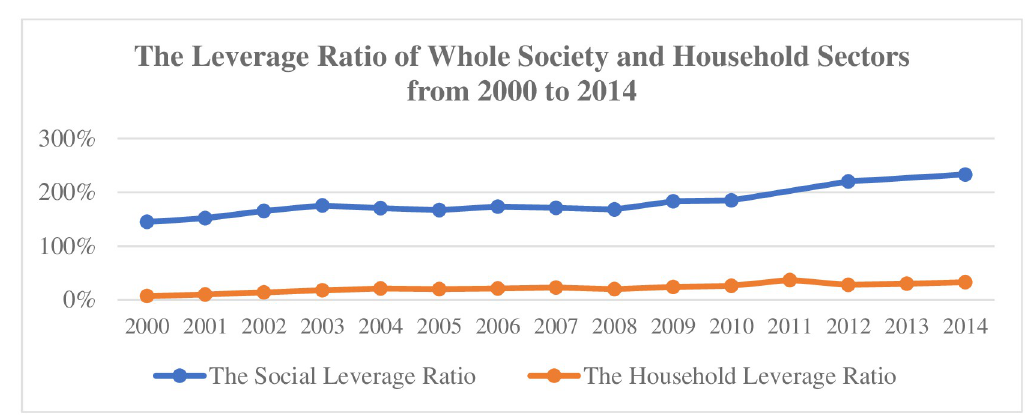
Fig 1. The leverage ratio of whole society and household sectors from 2000 to 2014. Source: China Statistical Yearbook.